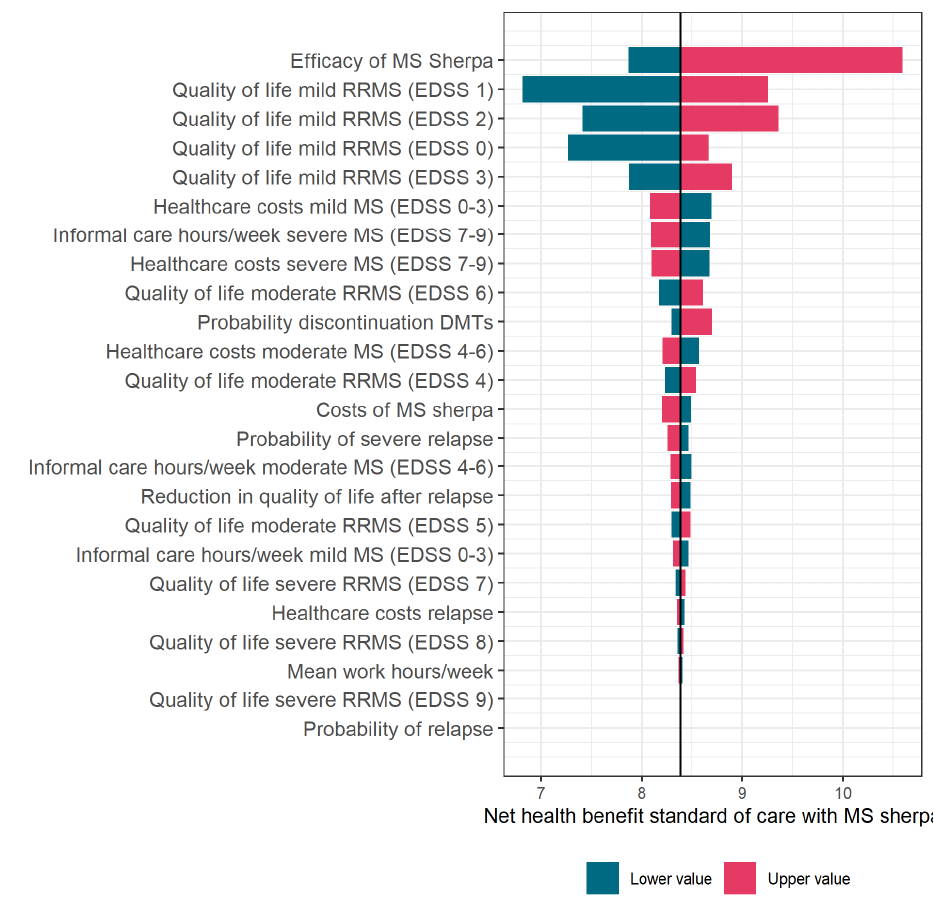
Figure 5. Tornado diagram with results of the univariate sensitivity analysis.